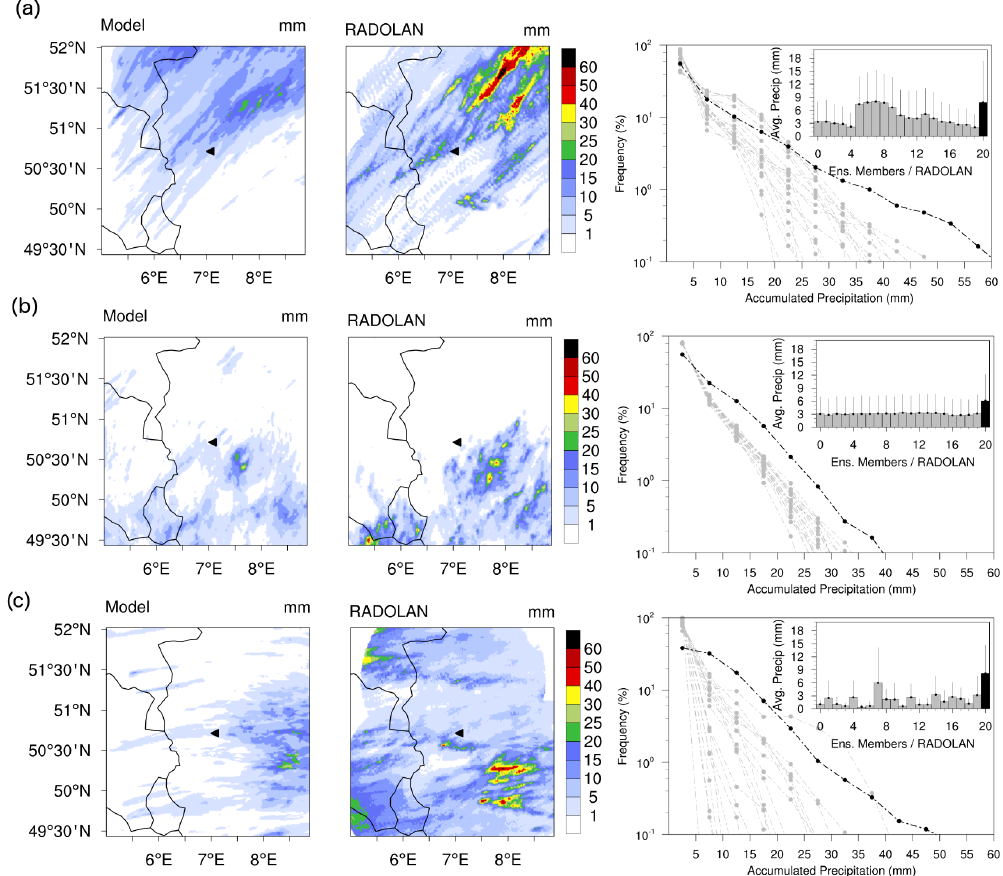
Figure 3. Spatial pattern and frequency distributions of accumulated precipitation over the Bonn radar domain for three case studies (a, b, c) . For each case studies, the left and middle panels show the spatial pattern of accumulated precipitation from model (ensemble average) and observations. The right panel shows the frequency distributions of accumulated precipitation for each ensemble member (dashed light grey line) and observation (dashed black line). The inset in the right panel shows the domain average accumulated precipitation for each ensemble member (light grey colour bar) and observation (black colour bar) with 1 standard deviation (solid line above the